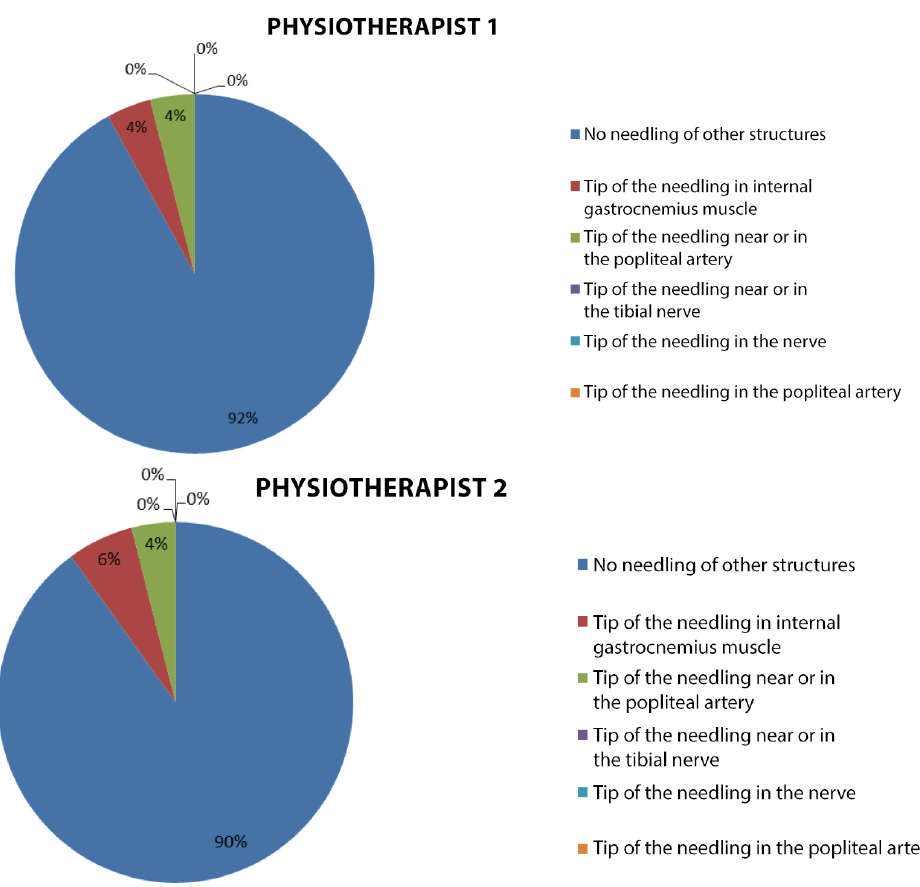
Figure 7. Sector diagram of each therapist’s punctures of other structures.